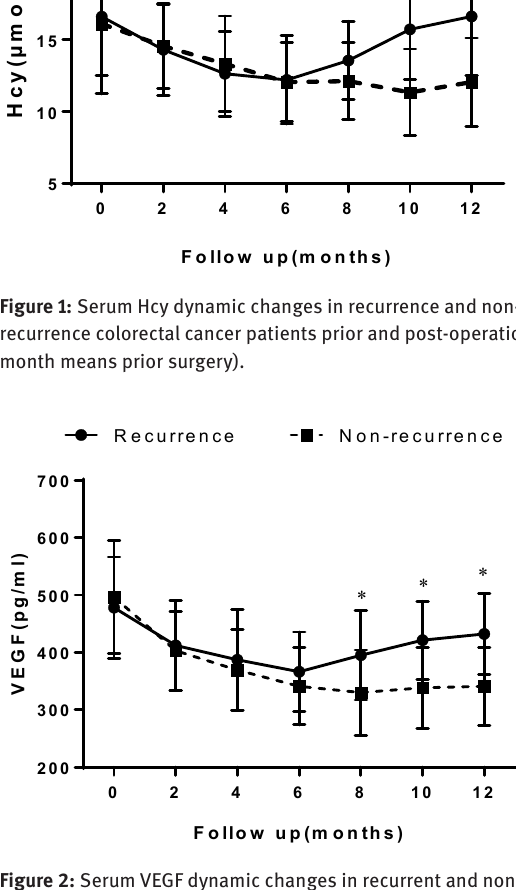
Figure 2: Serum VEGF dynamic changes in recurrent and non- recurrent colorectal cancer patients prior and post-operation (0 month means prior surgery).